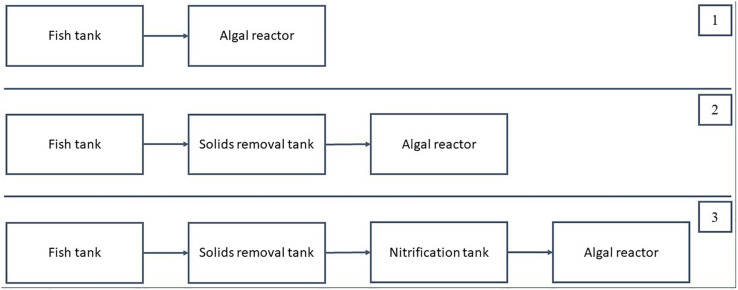
Recirculating aquaculture system (RAS) configurations with algal reactors. After the algal reactors, the water was either fully recirculated back into the RAS, or partly discharged to the environment. Configuration 1 was used by Studies 1 (Cahill et al., 2010), 2 (Valeta and Verdegem, 2015), and 7 (Gál et al., 2003). Configuration 2 was used by Studies 4 (SustainAqua, 2009), 5 (Pagand et al., 2000), and 6 (Deviller et al., 2004). Configuration 3 was used by Studies 3 (Huang et al., 2013) and 8 (Li et al., 2019).